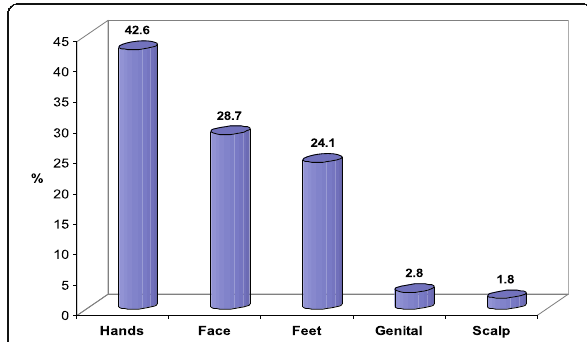
Fig. 2 Site of warts among primary school students, Tema District, Sohag, Egypt